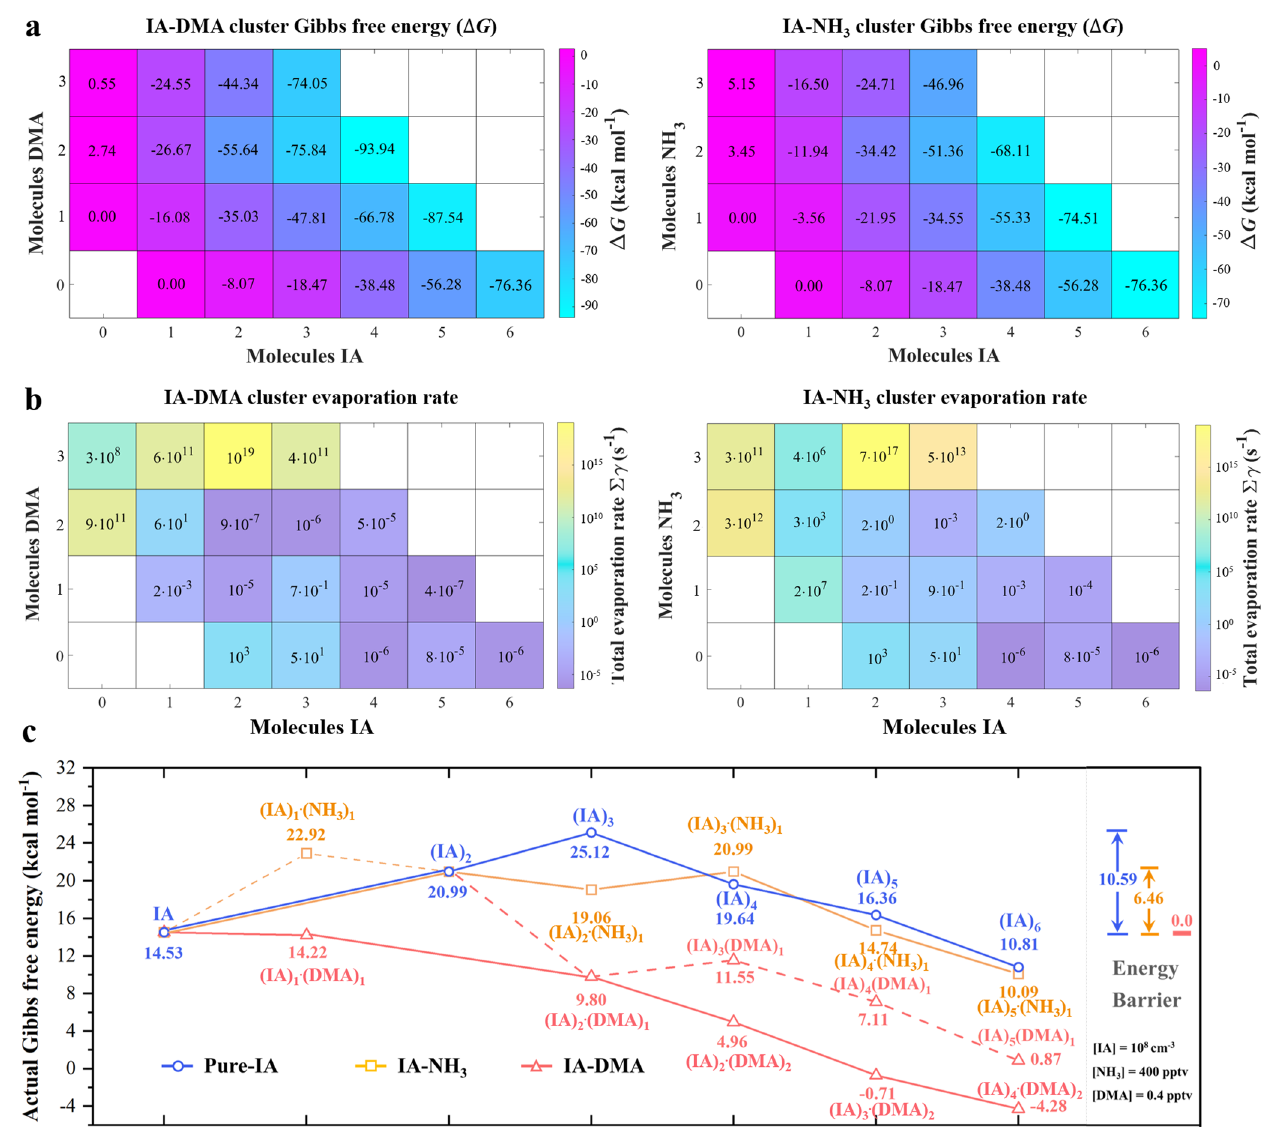
Fig. 3 Comparison of IA-DMA and IA-NH3 cluster properties. a Gibbs formation free energies ( Δ G ) of the (IA) x . (DMA) y and (IA) x . (NH 3 ) y (0 ≤ x ≤ 6, 0 ≤ y ≤ 3, x + y ≤ 6) clusters at the RI-CC2/aug-cc - pVTZ-PP// ω B97XD/6-311 ++ G(3df,3pd) + aug-cc-pVTZ-PP level of theory, T = 278 K, and p = 1 atm. b the total evaporation rates ( ∑ γ in s − 1 ) and c the actual Gibbs free energy (Eq. 3) of the corresponding clusters. The solid and dashed lines represent the primary and secondary paths,